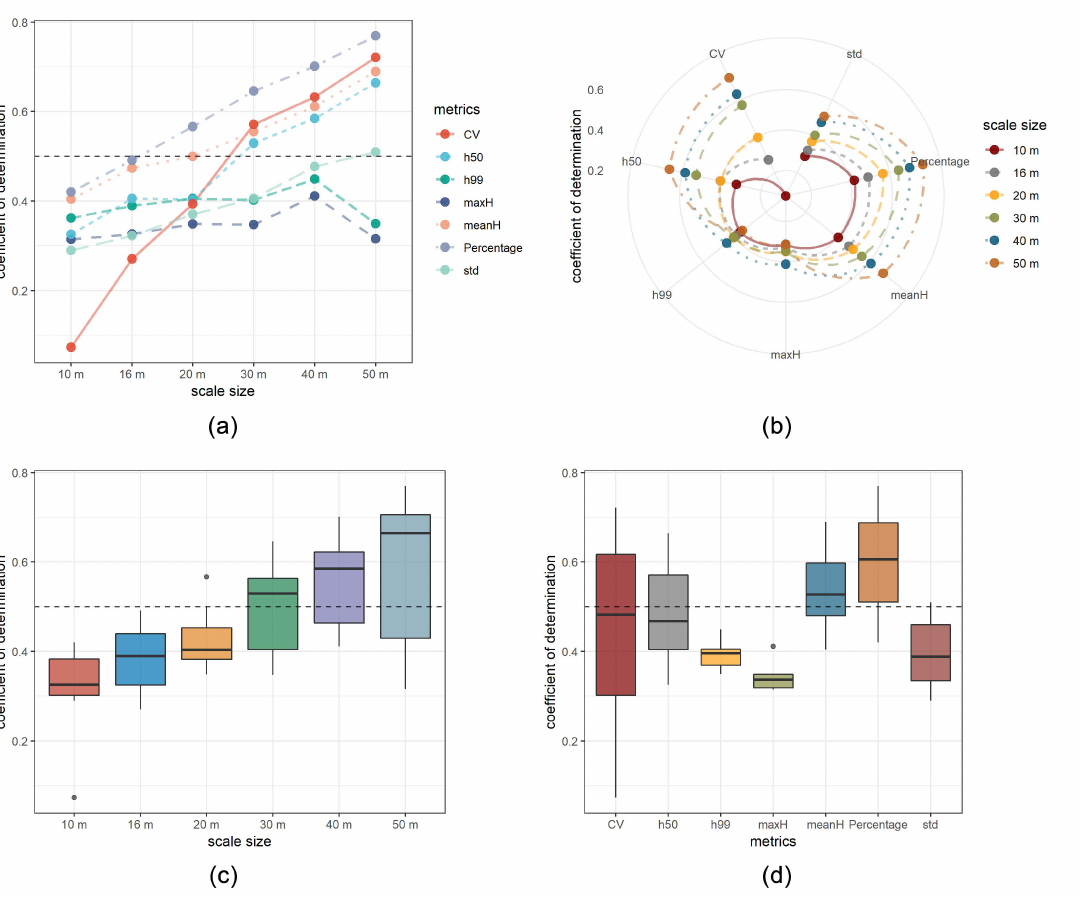
Figure 16. The sensitivity analyses between the SIMPL and G-LiHT data in Howland site for different scale